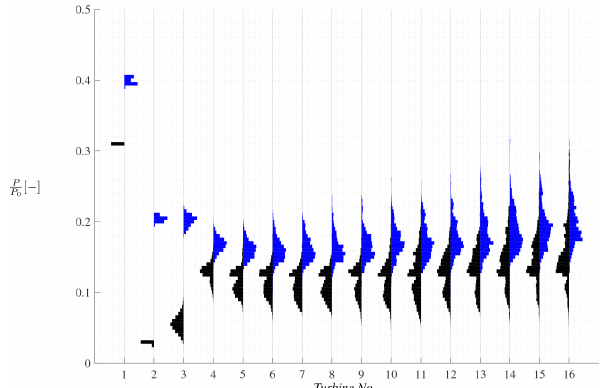
Figure 7. Mean power production of all turbines from the sixth to the end of the row for all simulations as function of representative turbine spacing. The mean power productions have been normalized by the mean power production of first wind turbine. Error bars show standard deviation of all the 10min periods. Simulations with turbu- lence intensity of 0%, 3%, 10% and 15% are shown in green, blue, cyan, and red, respectively. Two simulations with U 0 = 15ms − 1 are shown in gray, which have turbulence intensities of 0% and 15%. DTU results are plotted with circles, FW with triangles and UU with squares. Data from Stevens et al. (2015a), which used a constant C T = 0 . 75, are included for comparison. The underlying dashed contours indicate the asymptotic expression (Eq. 12) from Jensen (1983) for two different α parameters, while the full lines are contours from Frandsen and Madsen (2003) for two different z 0